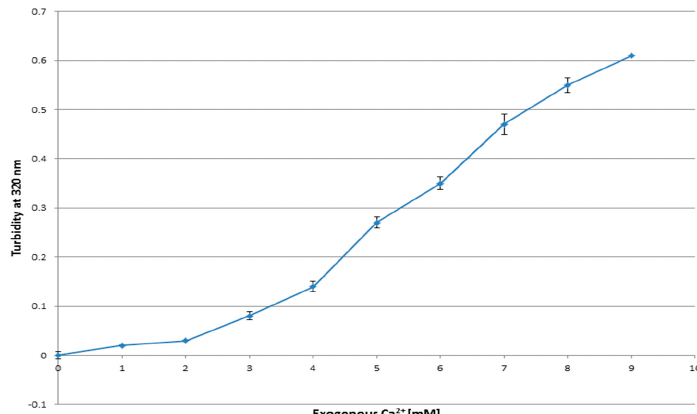
Figure 1 . Apatite was formed by addition of 1 to 9 μ L of exogenous Ca 2+ from 1 mM CaCl 2 to bicarbonated DMEM (pH 7.5). After 30 min of incubation at 37 °C turbidity was measured at 320 nm against fresh media as a blank. The experiment was perfomed in duplicate and data are presented as the mean ± SD.